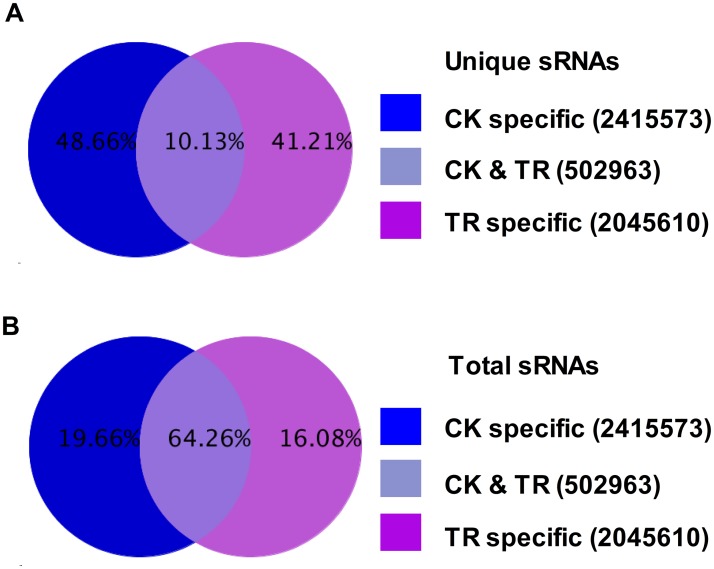
Common and specific sequences between CK and TR lirbary.